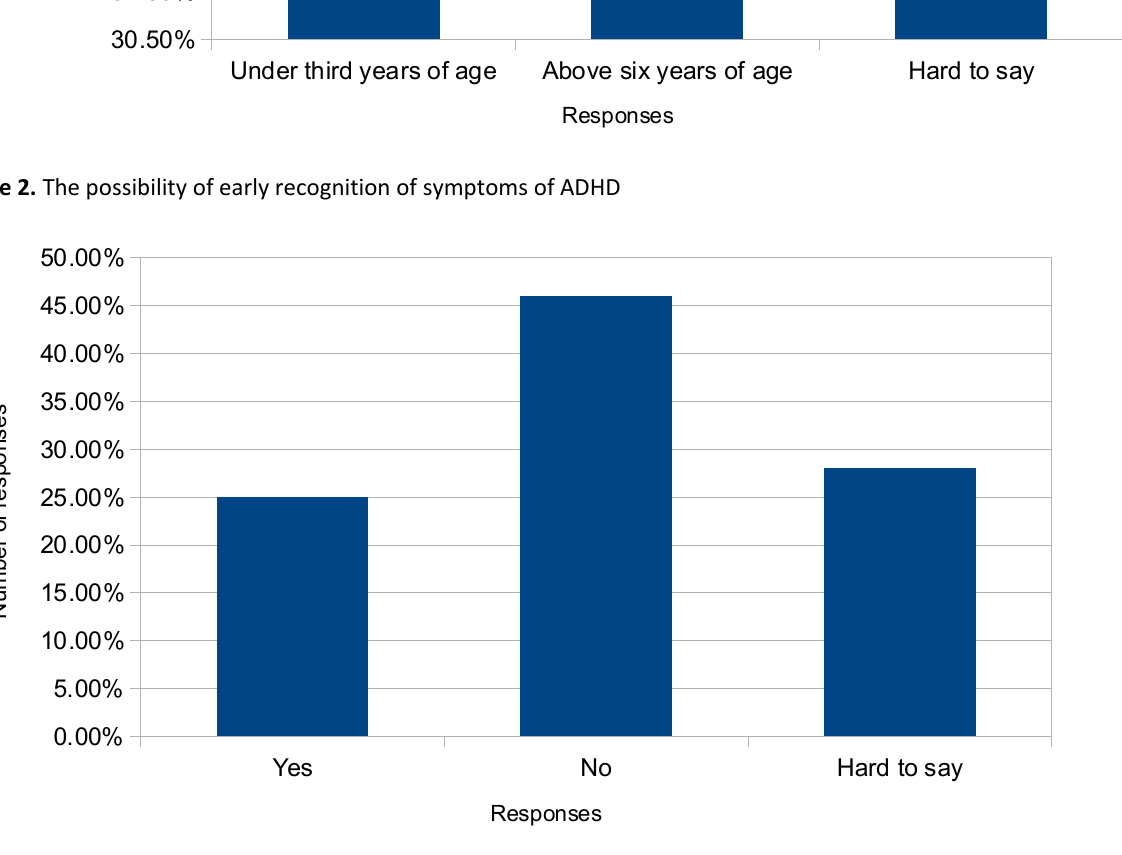
Figure 3. Disappearance of ADHD symptoms with the age of the